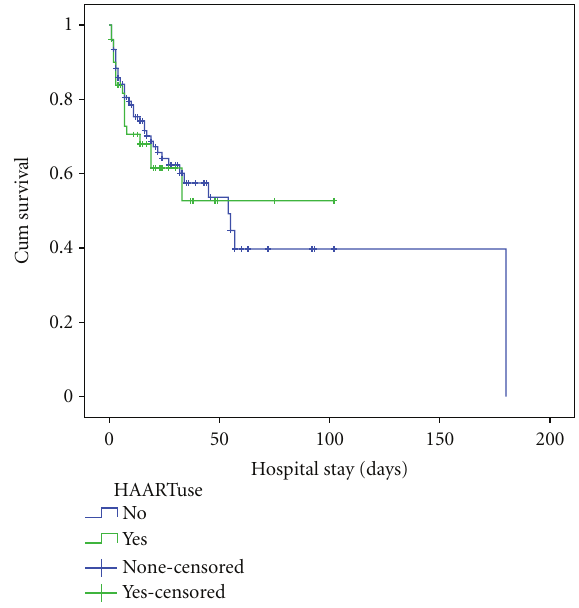
Figure 1: Survival after hospitalisation in relation to antiretroviral status—no significant di ff erence in survival rates were observed between both ART groups (Log rank P = 0.65, Breslow P = 0.44). Survival rates dropped sharply in both ART groups within the first 10 days of